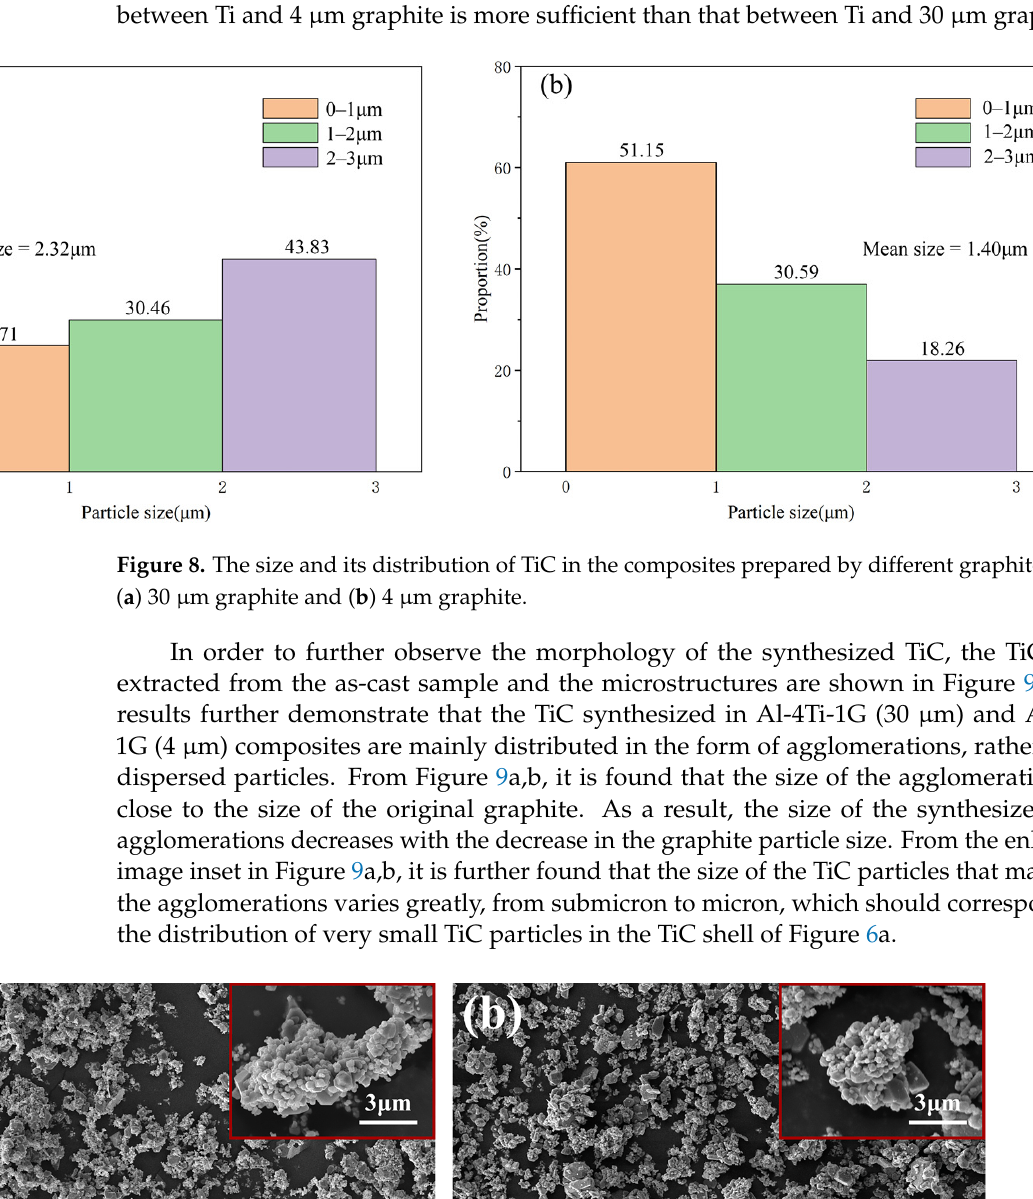
Figure 7. EDS mapping analysis of Al-4Ti-1C composites prepared by 4 μ m graphite: ( a ) microstructure and ( b – d ) mapping micrographs for Al, Ti, and C elements.